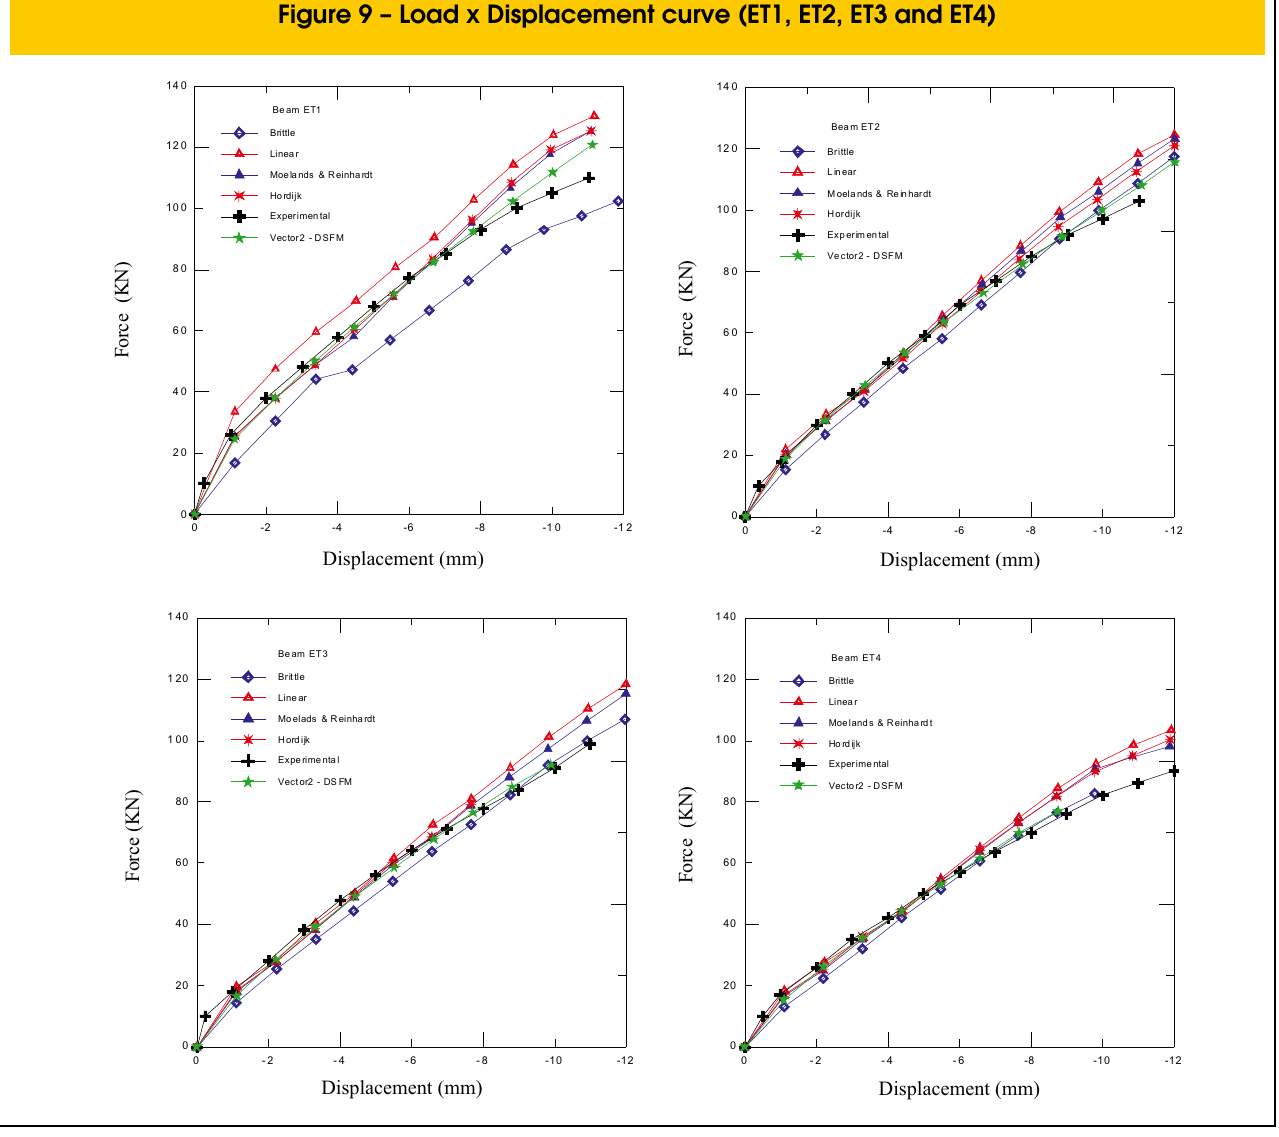
Figure 9 – Load x Displacement curve (ET1, ET2, ET3 and